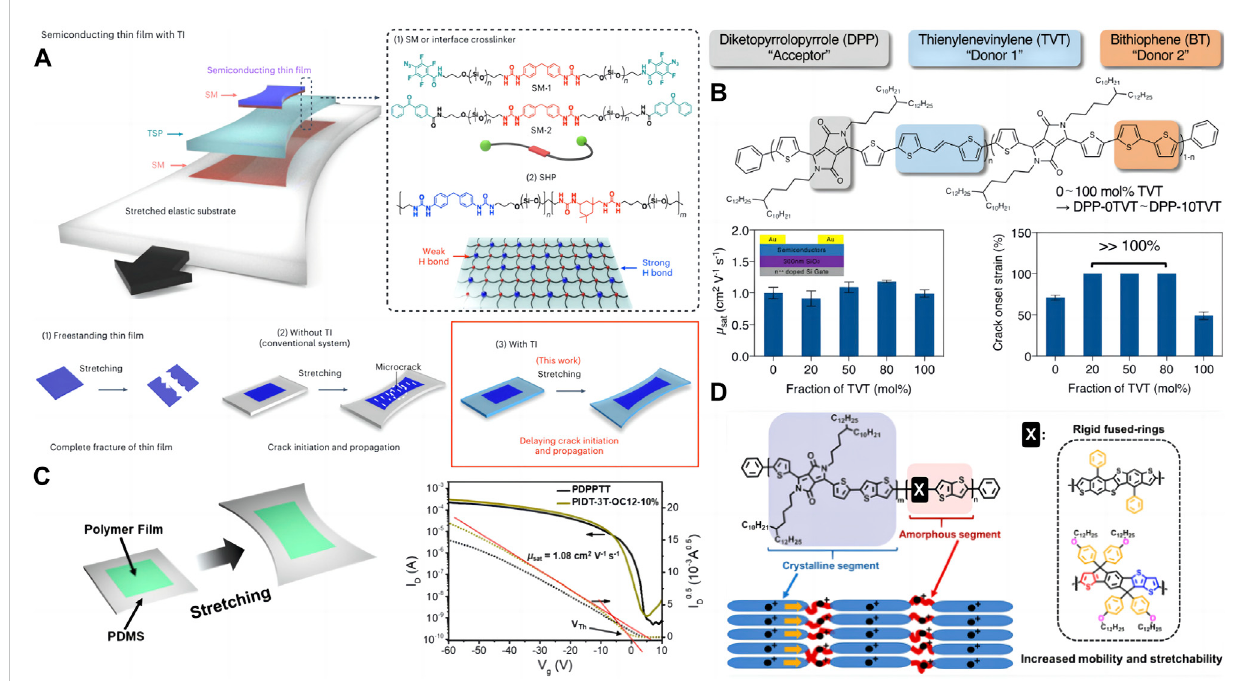
FIGURE 1 (A) Schematic of a TI between a semiconducting fi lm and an elastic substrate. The TI bonding is enabled by two essential chemical components: (1) SM and (2) siloxane-based SHP capable of self-recoverable energy dissipation. A TSP is composed of a mixture of 90 wt% SHP as the energy-dissipating matrix and 10 wt% SM as the crosslinker. Schematic of the fracture conditions of a polymer thin fi lm under various conditions. Under the freestanding condition (1), a polymer thin fi lm undergoes brittle fracture separated into two pieces by stretching. When the thin fi lm is attached onto an elastic polymer substrate (2), microcracks form in the polymer thin fi lm instead of complete fracture. This work shows that embedding a TI layer delay crack initiationandpropagation(3)(Kangetal.,2022). (B)